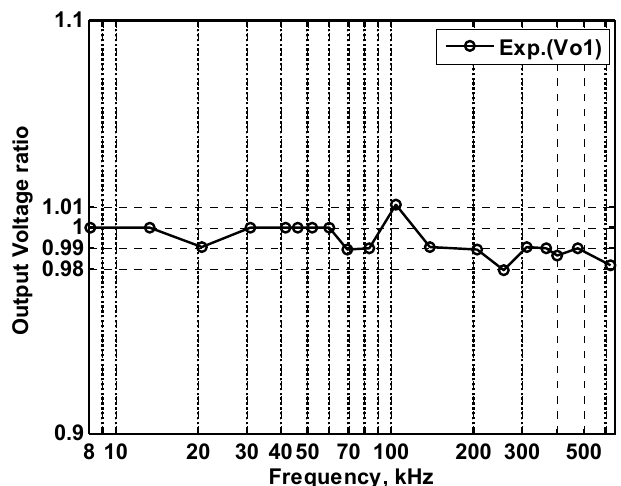
Figure 21. The measured relationship between the oscillation frequency and the magnitude ratio of quadrature output voltages.